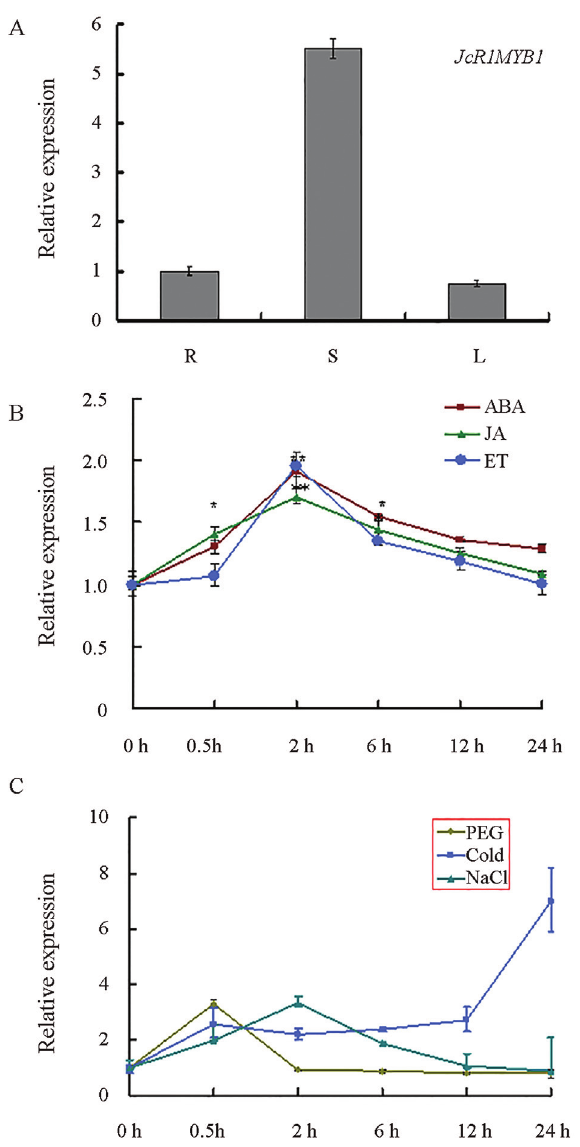
Figure 2 - Expression of JcR1MYB1. (A) JcR1MYB1 expression in the roots (R), stems (S), and leaves (L) of J. curcas seedlings. Relative